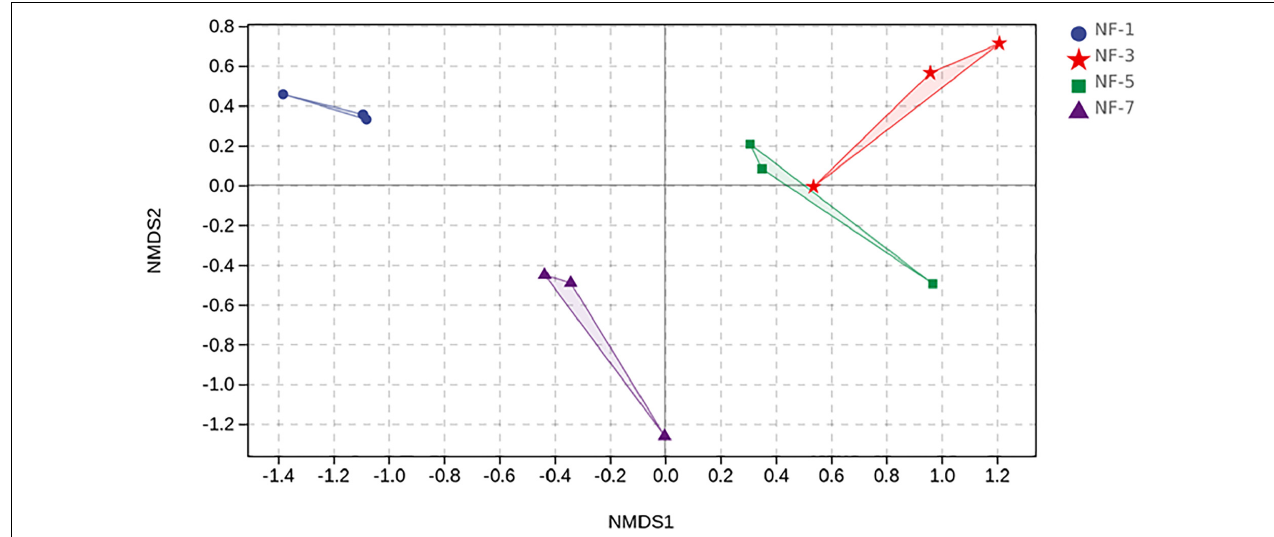
FIGURE 3 | NMDS ordination. NMDS plots demonstrate that sour porridge in different fermentation periods are harboring different bacterial composition.